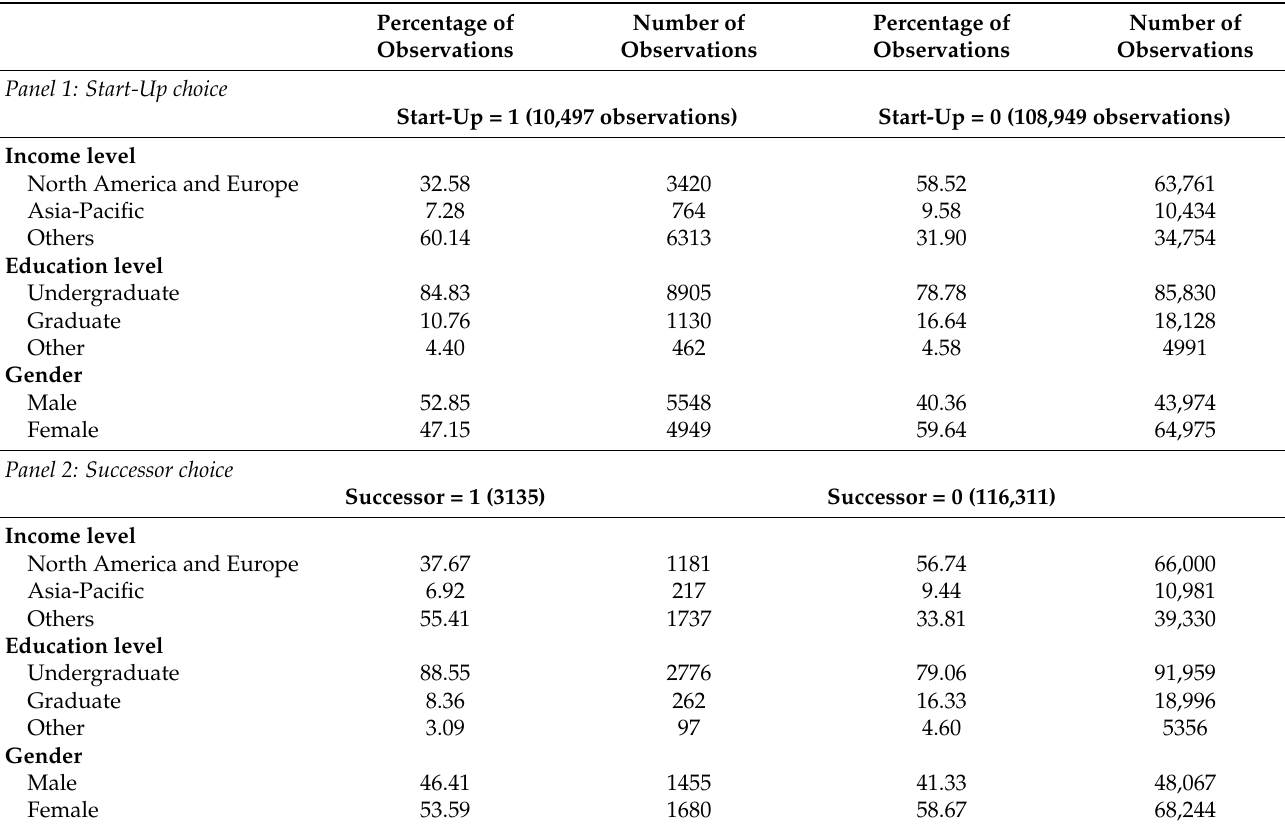
Table 4. Information about entrepreneurial intentions, across the total